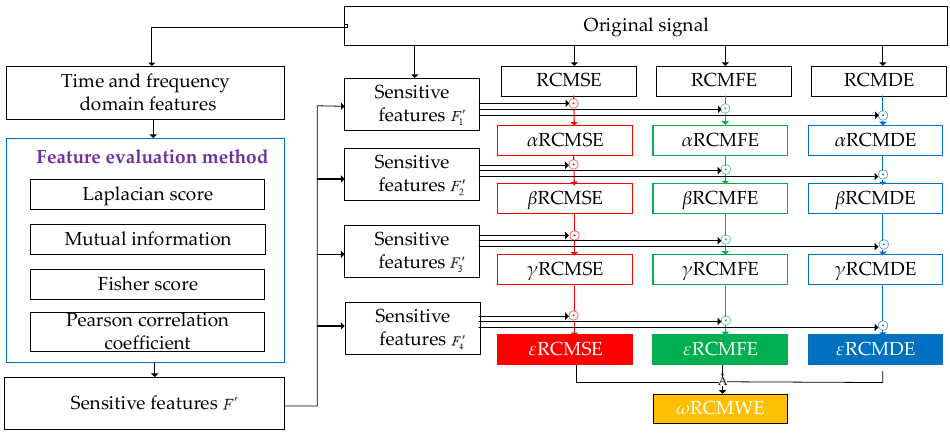
Figure 1. RCMWE characteristic index construction process.